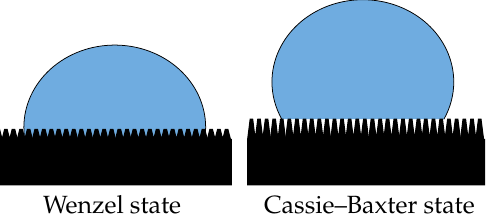
Figure A2. Droplet contact line for Wenzel and Cassie–Baxter wetting regimes. In the Wenzel regime, the droplet is in full contact with the entire surface; in the Cassie–Baxter regime, it only wets a fraction of the total